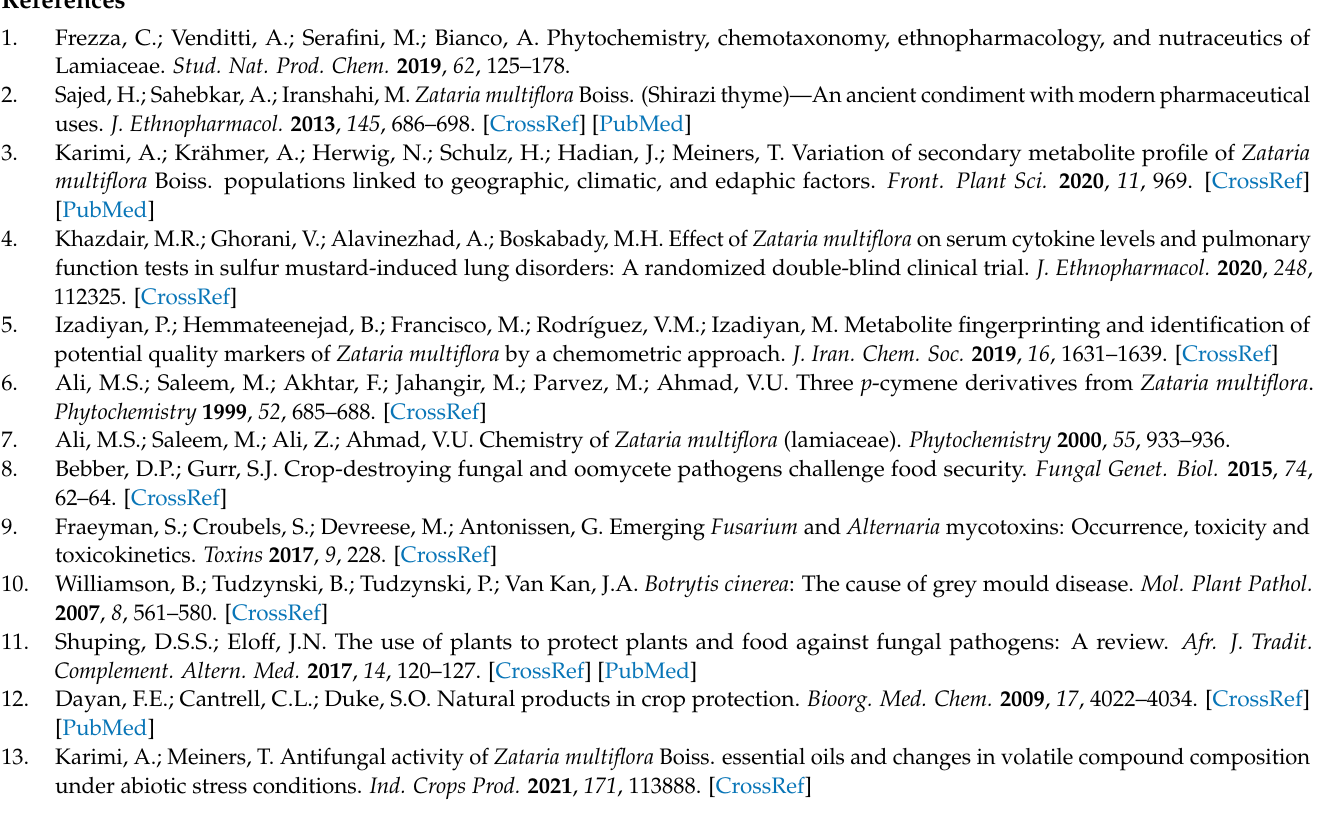
partial correlation network; Table S1. Chromatographic and tandem mass spectral data of annotated metabolites; Table S2. Antifungal activities of fractions; Table S3. Spearman’s correlation coefficients calculated from THQ glycoconjugates abundances and essential oil compounds; Table S4. General geographic and climatic information of sampled natural habitats of Z. multiflora ; Table S5. Commercial sources of reference compounds used for metabolite